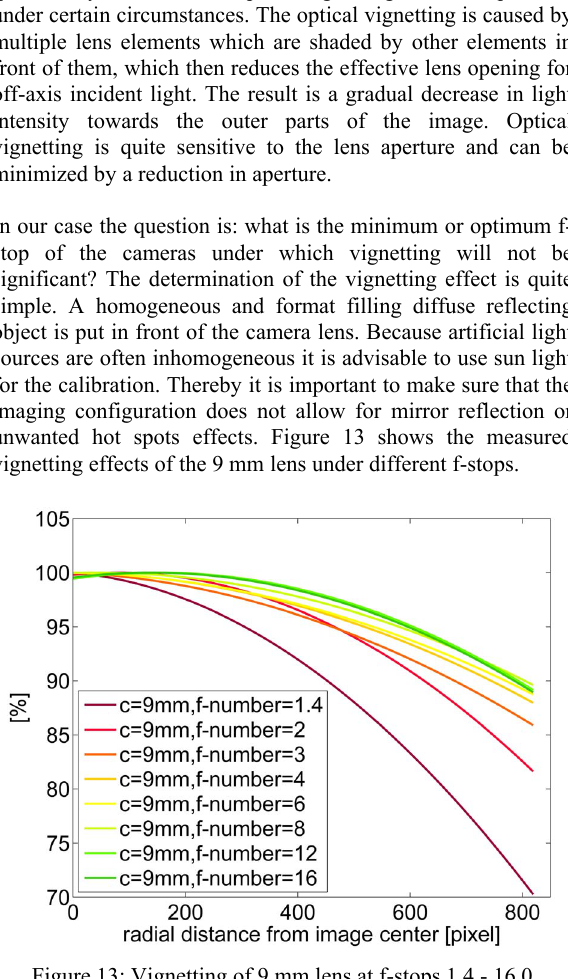
Figure 13: Vignetting of 9 mm lens at f-stops 1,4 - 16,0 For the 9 mm lens (Figure 13) shows a reduction of the vignetting with increasing f-numbers. The brightness falloff for f-numbers from 4 - 16 is significant and should be corrected. However it is lower than 10 % in the edges. For very low f- numbers the brightness falloff increases drastically.